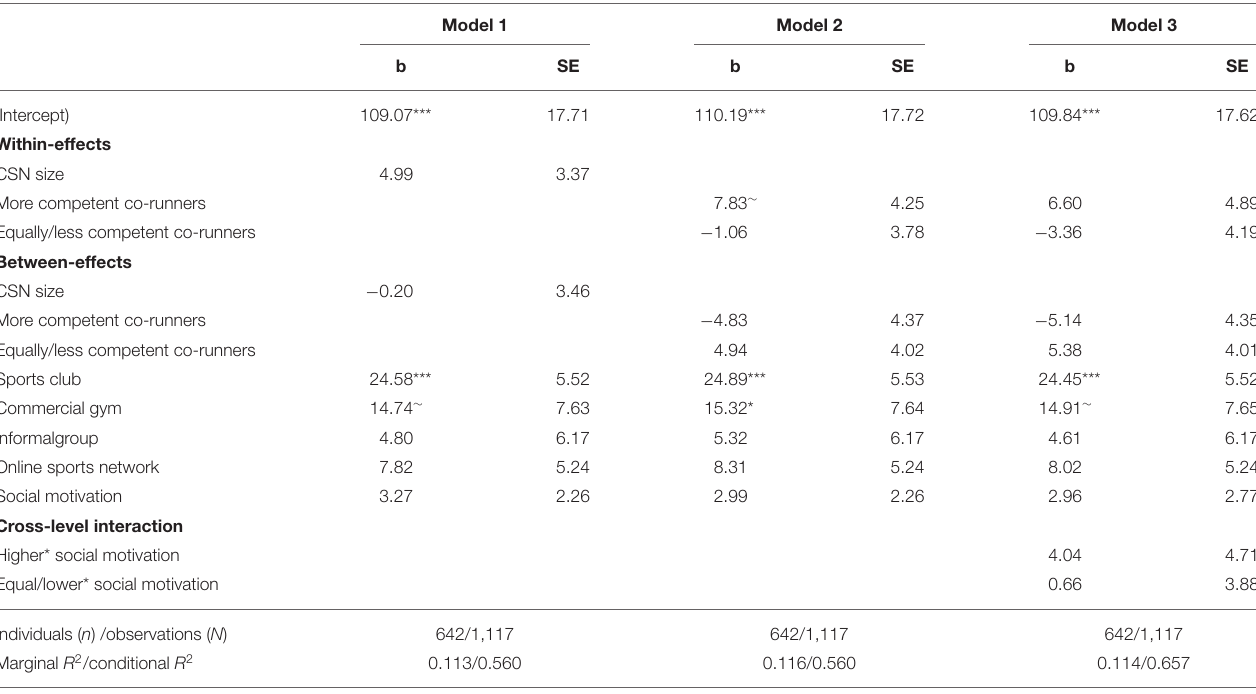
TABLE 2 | Between-within effects of number of more and equally/less competent co-runners,